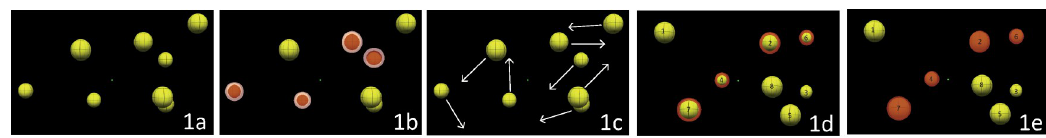
Fig 1. Five steps of the 3D-MOT task: (a) presentation phase, where 8 spheres are shown in a 3D volume space; (b) indexing phase, where 4 spheres (targets) change color (red) and are highlighted by a halo for 1 second; (c) movement phase, where the targets indexed in stage b return to their original form and color and all spheres move for 8 seconds crisscrossing and bouncing off of each other and the virtual 3D volume cube walls that are not otherwise visible; and (d) identification phase, where the spheres come to a halt and the observer has to identify the 4 spheres originally indexed in phase (b). The spheres are individually tagged with a number so the observer can report the number; (e) Feedback was given to the